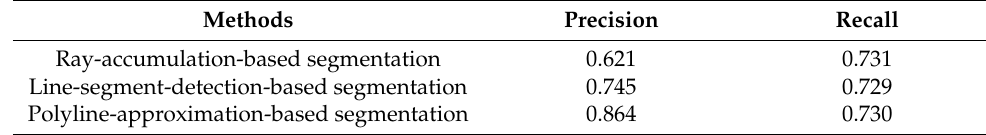
Table 1. Comparisons of the precision and recall rates among different edge segmentation